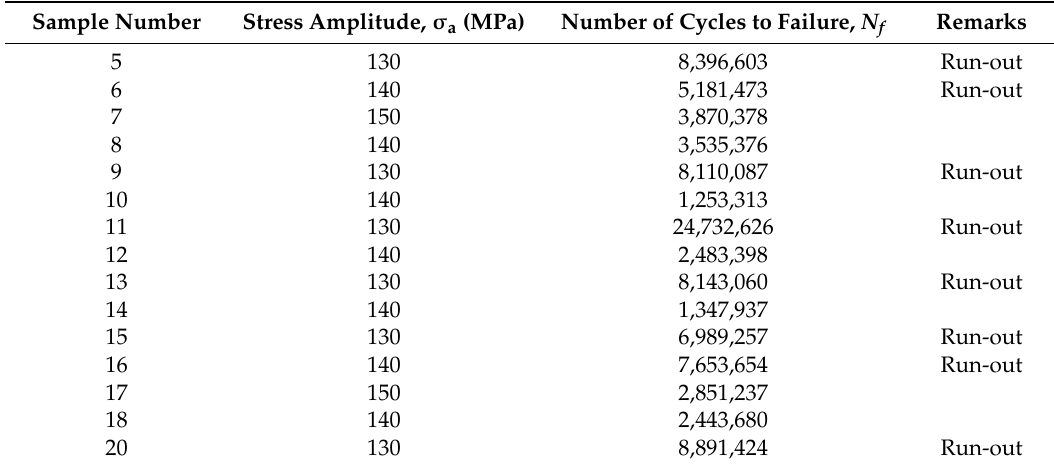
Table 4. Results of the rotating bending fatigue